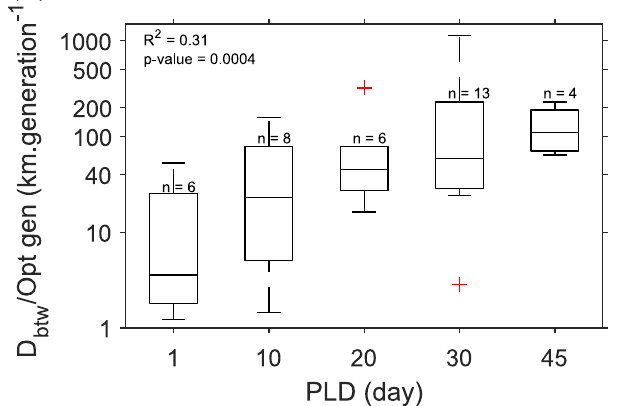
Fig. 5| Sensitivity ofthemulti-generationimplicitdispersalmodelpredictions to dispersal trait and sampling design. Correlation ( R 2 = 0.31*** using a linear regression model fi t) between the PLDs categories ( x -axis) and the proxy of sam- plingextent D btw dividedbytheoptimalnumberofmodelledgenerations( y -axis). n = number of studies whose model predictions of genetic observations are sig- ni fi cant per PLD categories. On each box, the central mark, the bottom and top edges indicate the indicates the median, the 25th and the 75th percentiles, respectively. The whiskersextend to the most extreme data points not considered outliers, and the outliers are plotted individually using a cross symbol. Note that Susini et al. 91 has been removed from this fi gure as it displays the minimal number of localitiesof ourcompilation(i.e., three localitieswhiletwosampled populations are indeed compassed in the same locality), which does not permit a robust eva- luationofD btw /Optgenratio.Whenconsideringthisstudy, R 2 =0.23***.Sourcedata are provided as a Source Data fi